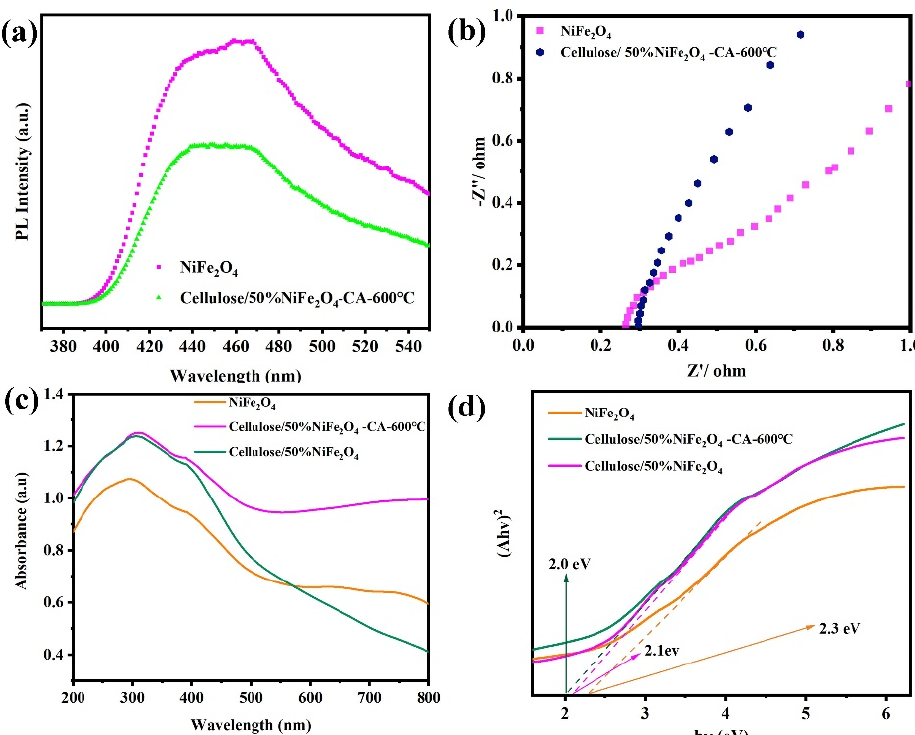
Figure 4. ( a ) Electrochemical impedance spectroscopy; ( b ) FLS of NiFe 2 O 4 and cellulose/50%NiFe 2 O 4 -CA-600 ◦ C ( λ ex = 325 nm); ( c ) DRS and ( d ) Tauc plots of NiFe 2 O 4 , cellulose/50%NiFe 2 O 4 -CA-600 ◦ C, cellulose/50%NiFe 2 O 4 .